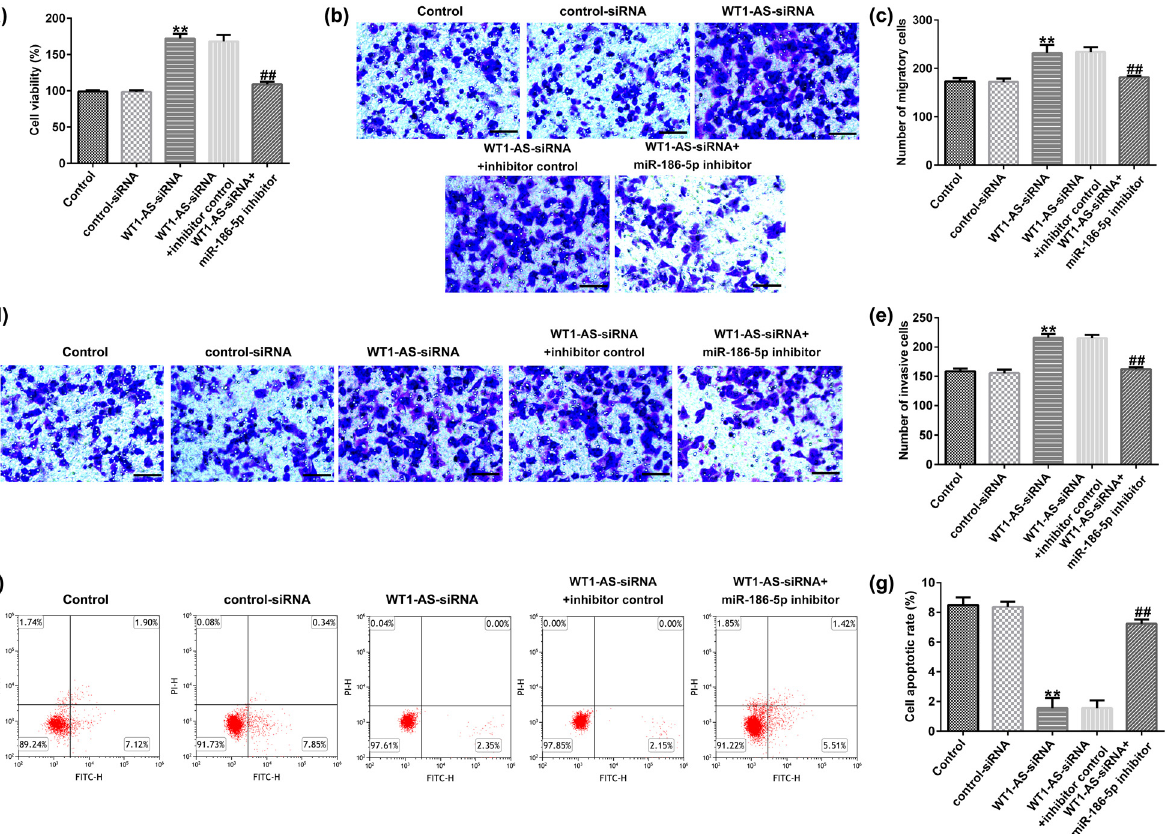
Figure 5: E ff ects of WT1 - AS - siRNA on the function of HTR - 8/SVneo cells. ( a ) Viability of HTR - 8/SVneo cells was checked by the MTT assay. HTR - 8/SVneo cell migration ( b ) and invasion ( d ) ( magni fi cation: × 100; bar = 100 μ m ) were evaluated using Transwell assay. The number of migratory cells ( c ) and invasive cells ( e ) were determined. ( f and g ) Flow cytometry was applied to assess apoptosis of HTR - 8/SVneo cells. One - way ANOVA followed by Tukey ’ s post hoc test was used for data analysis. ** P < 0.01 vs control - siRNA; ## P < 0.01 vs WT1 - AS - siRNA + inhibitor control. WT1 - AS, WT1 antisense RNA; si, small